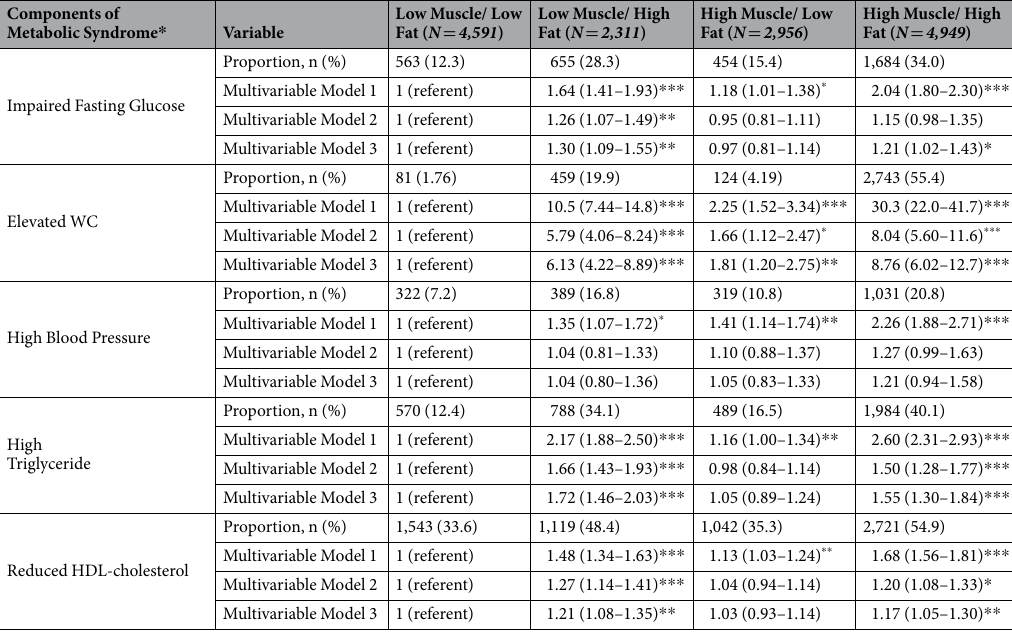
Table 2. Incidence rate ratio of (95% confidence intervals) for metabolic syndrome components by muscle mass and fat mass. * Includes (1) Impaired Fasting Glucose ( ≥ 100 mg/dL), (2) Elevated WC ( > 90 cm for men and > 85 cm for women), (3) High Blood Pressure (SBP: ≥ 130 mmHg and DBP: ≥ 85 mmHg), (4) High Triglyceride ( ≥ 150 mg/dL), (5) Reduced HDL-cholesterol ( < 50 mg/dL for men and < 40 mg/dL for women). Data presented are n (%) and IRR (95% CI). Multivariable Model 1: Adjusted for age and sex. Multivariable Model 2: Adjusted for age, sex, education, employment status, area of residence, household income, smoking, alcohol consumption, sleep duration, physical activity, BMI, and presence of comorbidity. Multivariable Model 3: Adjusted for age, sex, education, employment status, area of residence, household income, smoking, alcohol consumption, sleep duration, physical activity, BMI, and presence of comorbidity, total energy intake, vitamin C, niacin, sodium, calcium, and fiber. Abbreviations: IRR, Incidence Rate Ratio; CI, Confidence Interval WC, Waist Circumference; SBP, Systolic Blood Pressure; DBP, Diastolic Blood Pressure; HDL, High Density Lipoproteins; BMI, Body Mass Index. Note: Each category of muscle mass and fat mass is compared to low muscle/low fat group (reference). * p < 0.05, ** p < 0.01, *** p < 0.001 (reference group is low muscle/low fat).